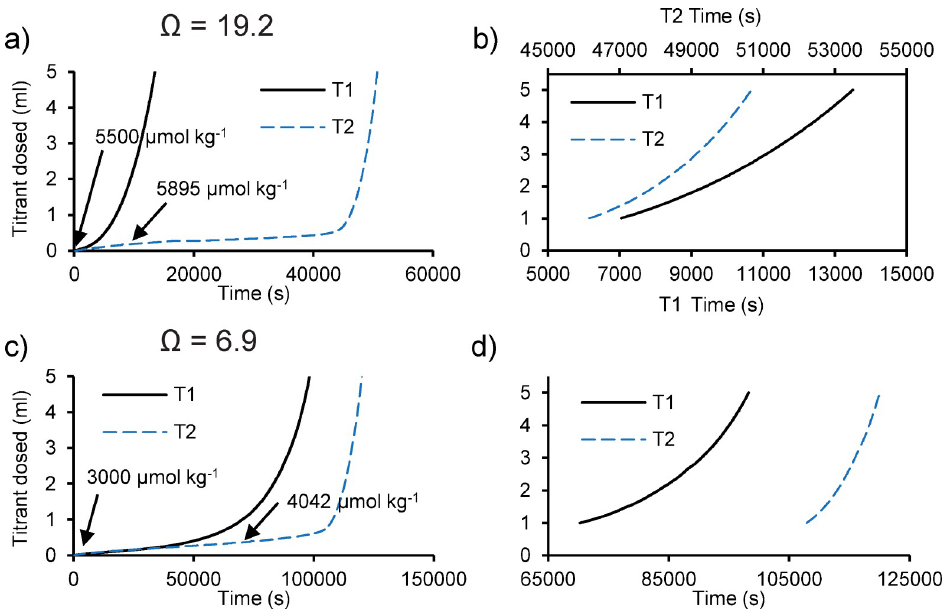
Fig 3. Profiles of titrant volume dosed over time in duplicate unseeded experiments in artificial seawater. a), b) O = 19.2 and c), d) O = 6.9. b) and d) showed expanded x axes to compare rates of dosing of 1–5 mLs of titrant between duplicates (T1 and T2, show data from two titrators). Measured [DIC] at the start and during 2 of the precipitations are overlaid onto the